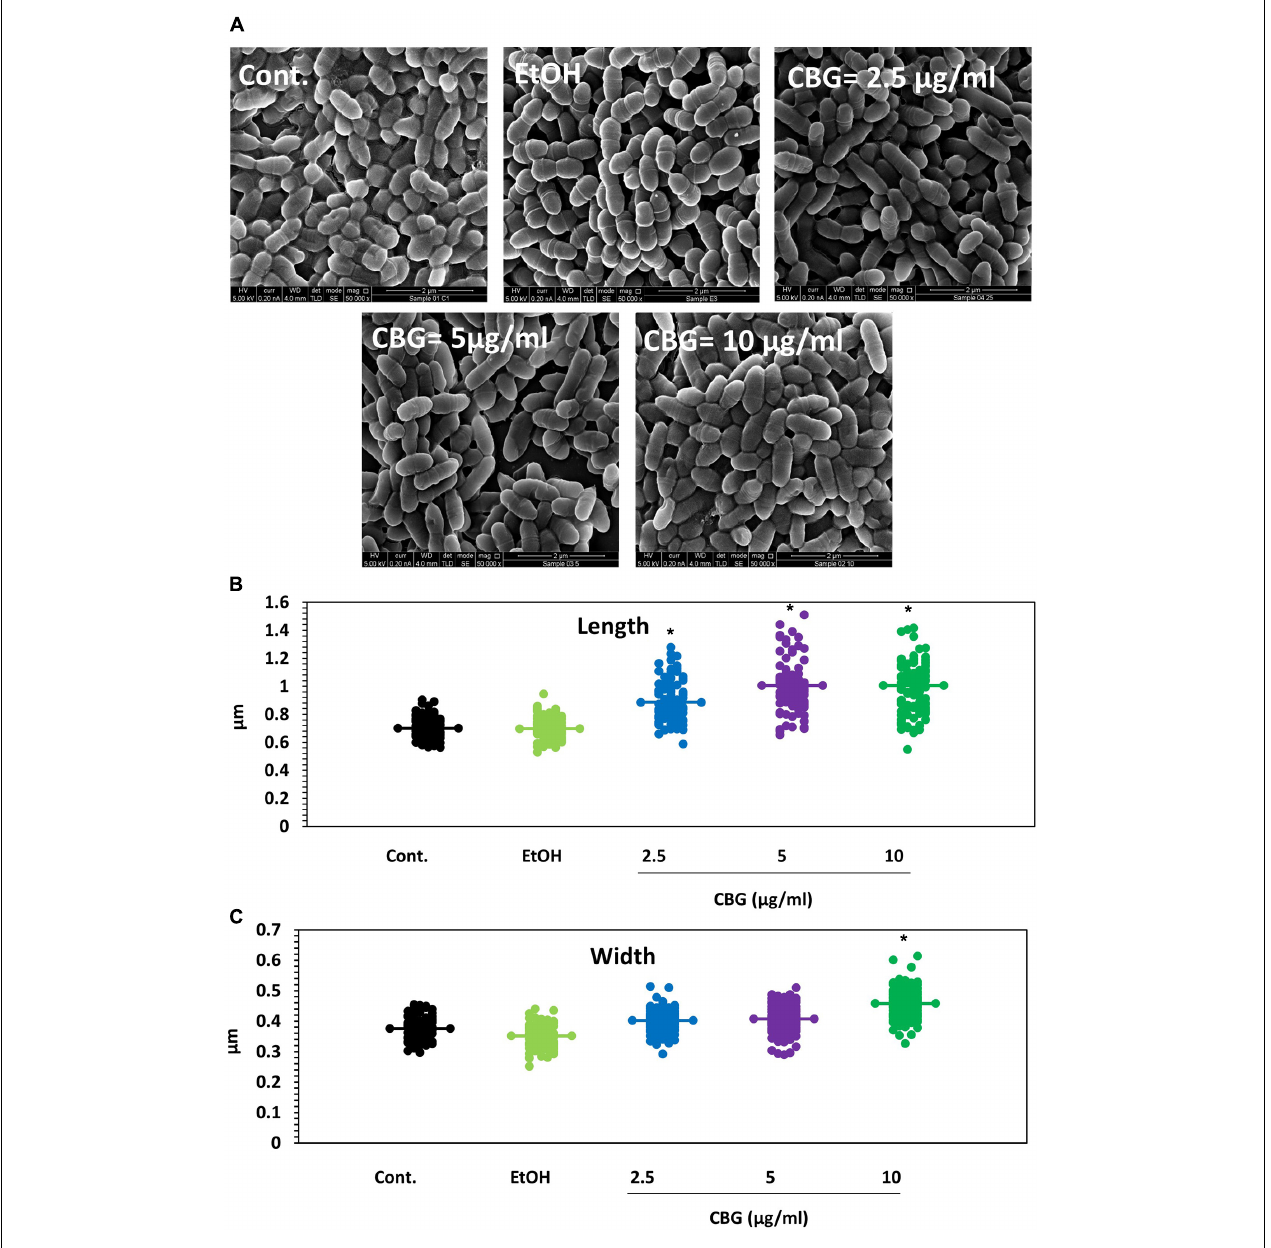
FIGURE 2 | CBG alters the membrane structure and the size of S. mutans . (A) HR-SEM images (x50000) of control bacteria or bacteria treated with different concentrations of CBG (0–10 µ g/ml) for 4 h. (B) The average length of untreated and CBG (0–10 µ g/ml)-treated bacteria. n = 200; * p < 0.05. (C) The average width of untreated and CBG (0–10 µ g/ml)-treated bacteria. n = 200; * p <